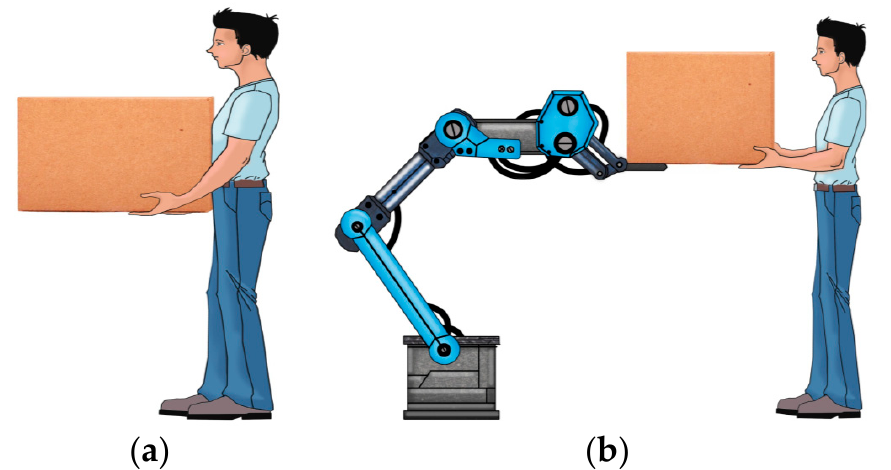
Figure 1. ( a ) Manual manipulation of an object where a human perceives the actual weight of the object; ( b ) manipulation of an object with a power assist robot where a human perceives a reduced weight of the object. Ideally, the perceived weight of the same object is very less for the power assist case because the robot reduces the perceived weight. For the power assist case, the object is carried by the robot, and the human’s applied forces only control the motions.